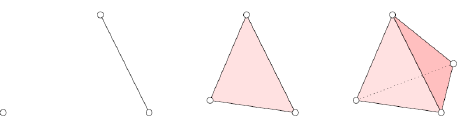
Figure 1. Examples of simplices: a point (dimension equal to 0, or 0-simplex), a line segment (dimension equal to 1, a 1-simplex), a triangle (dimension equal to 2, a 2-simplex) and a tetrahedron (dimension equal to 3, a 3-simplex). Image from [7].